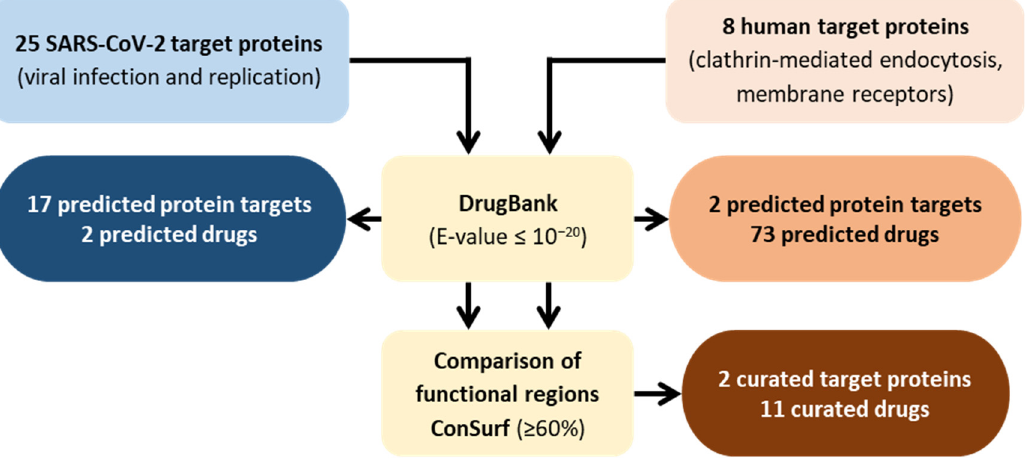
Figure 1. Flowchart summarizing the in silico drug repurposing strategy and corresponding